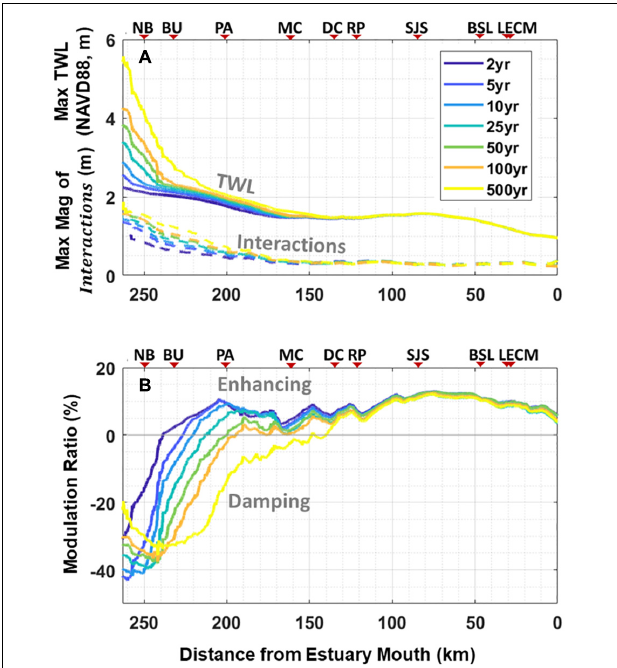
FIGURE 15 | Along-estuary variations of (A) peak magnitude of non-linear interactions and peak TWL corresponding to a range of return periods (2–500 years ARI) from the Delaware River; (B) modulation ratio by TSRI on